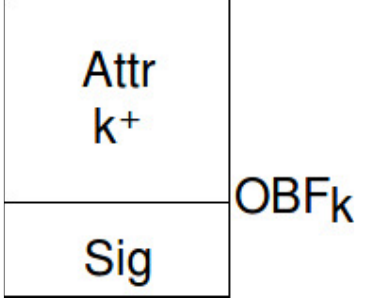
Figure 2. Bit commitment obfuscated